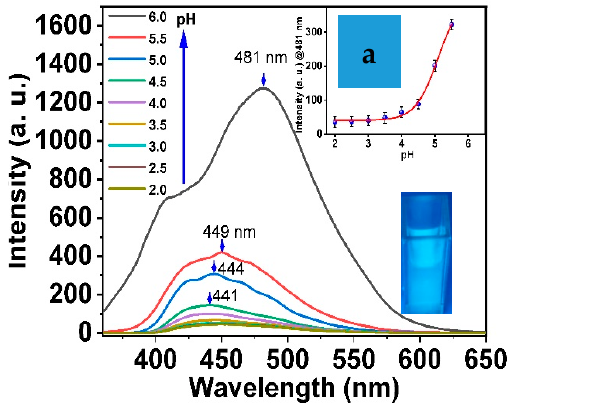
Figure 3. Emission spectra of IXZD at various pH values: ( a ) pH range (2–6); ( b ) pH range (6–12).